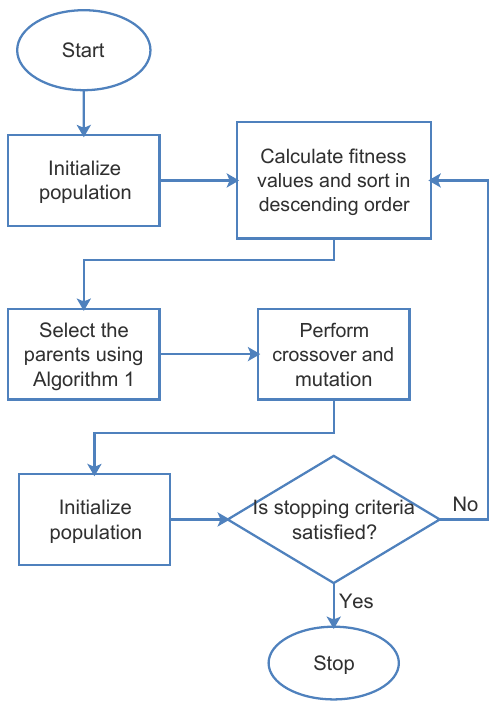
Figure 1. Flowchart of the